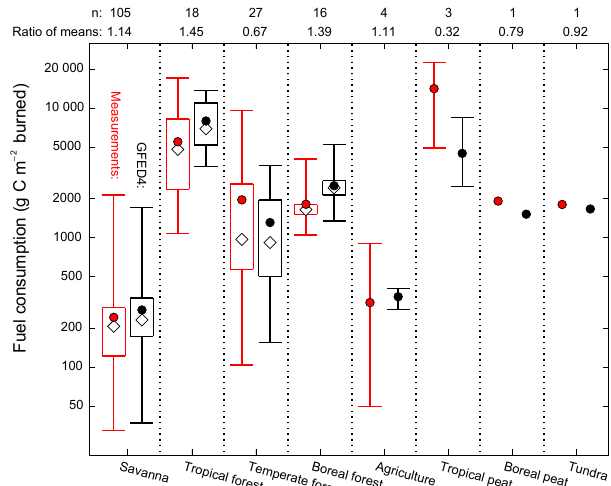
Figure 12. Measured and modeled fuel consumption for various biomes showing the range (whiskers), mean (colored dots and di- amonds), median (open dots and diamonds), and 25th and 75th percentiles (boxes) for those biomes with more than 10 measure- ments. Comparison is based on the meta-analysis of van Leeuwen et al. (2014) and collocated 0.25 ◦ grid cells. The time periods of measurement and model do not necessarily overlap. “ n ” indicates the number of measurements for each biome. Note the logarithmic